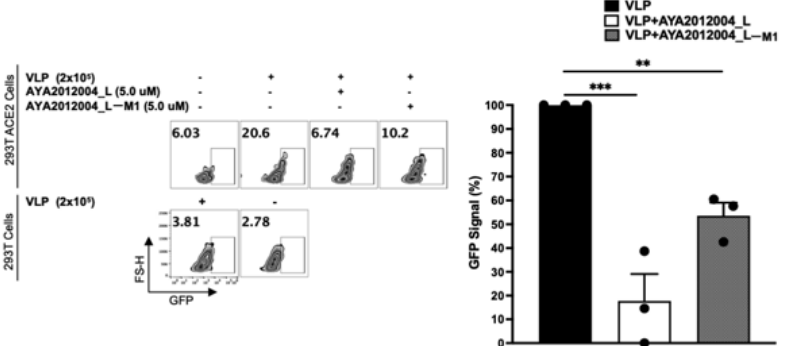
Figure 10. Blocking of the SARS-CoV-2 trimer S protein VLPs uptake to ACE2 receptors of transfected HEK293T cells by aptamers. VLPs were pre-incubated for 30 min with or without aptamers (5 µ M) in PBS plus 1.0 mM MgCl 2 at room temperature as indicated. Pre-incubated VLPs of each condition were then added to mock or ACE2 receptors overexpressing HEK293T cells and incubated at 37 ◦ C in a humidified 5% CO 2 atmosphere. After 72 hr, cells were washed two times with 1X PBS and then stained with fixable viability dye eFluor 450 at 4 ◦ C for 30 min. The binding and subsequent uptake of VLPs to ACE2 receptors-transfected HEK293T cells in the presence or absence of aptamers was determined by flow cytometry. Data from one representative of three independent experiments are shown. Results are shown in percent of GFP signal of VLPs to HEK293T ACE2 cells. Error bars represent mean ± SD ( σ ). p -values were determined with one-way ANOVA, Dunnett’s multiple comparison test. ** denotes p < 0.002 and *** denotes p <